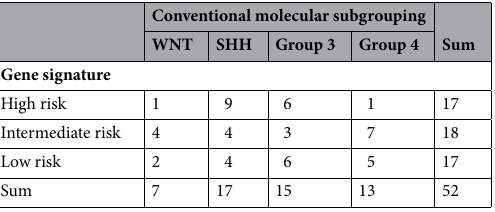
Table 2. Patient distributions in gene-signature risk subgroups and the conventional molecular